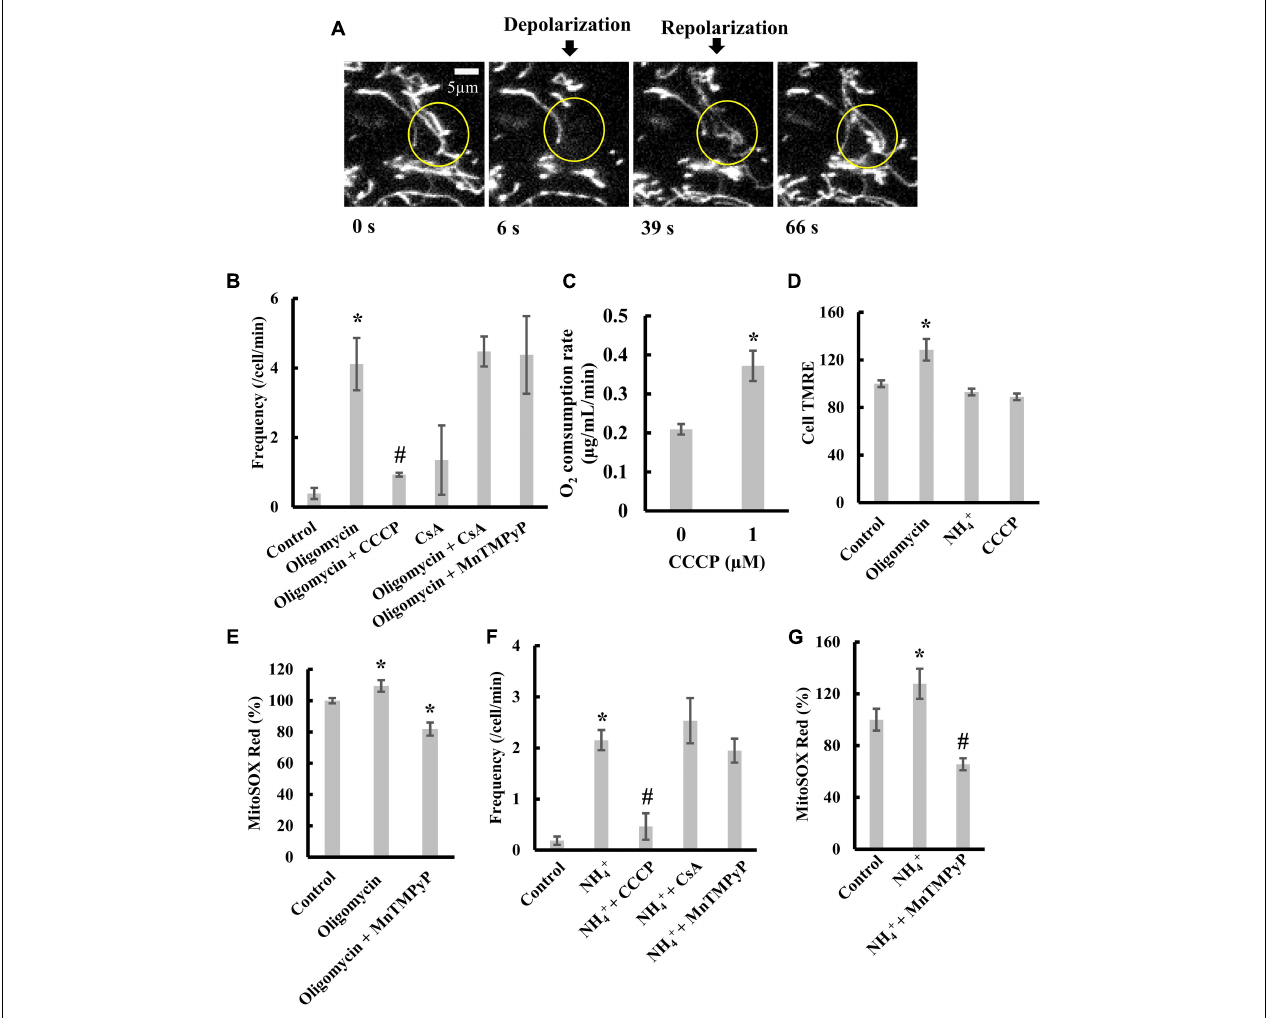
FIGURE 5 | Transient depolarization of mitochondria in H9c2 cells. (A) Time-resolved fluorescence images of TMRE in an H9c2 cell. Mitochondria in the indicated circle were transiently depolarized. (B) Effects of oligomycin and CCCP on the frequency of transient depolarization. (C) Effects of CCCP on respiration. (D) TMRE fluorescence in H9c2 cells in the presence of oligomycin, NH 4 + , and CCCP. The fluorescence of TMRE in control cells was set to 100%. (E) Effects of oligomycin on ROS production by mitochondria in cells. Cells were incubated with 5 µ M oligomycin at 37 ◦ C for 1 h before measurements. The fluorescence of MitoSOX in control cells was normalized to 100%. (F,G) Effects of NH 4 + on (F) transient depolarization and (G) ROS production. Cells were incubated with 20 mM NH 4 + at 37 ◦ C for 5 min before measurements. (B–G) CCCP, CsA, or MnTMPyP was added to cells, and they were incubated with 1 µ M CCCP for 30 min, 2 µ M CsA for 1 h, and 25 µ M MnTMPyP for 1 h at 37 ◦ C before observation. Values represent the mean ± SEM ( n > 10 for B,D–G , n = 3 for C ). * p < 0.05 vs. control for (B,D–G) ; 0 µ M for (C) ; # p < 0.05 vs. oligomycin for (B) , and NH 4 + for (F,G) .